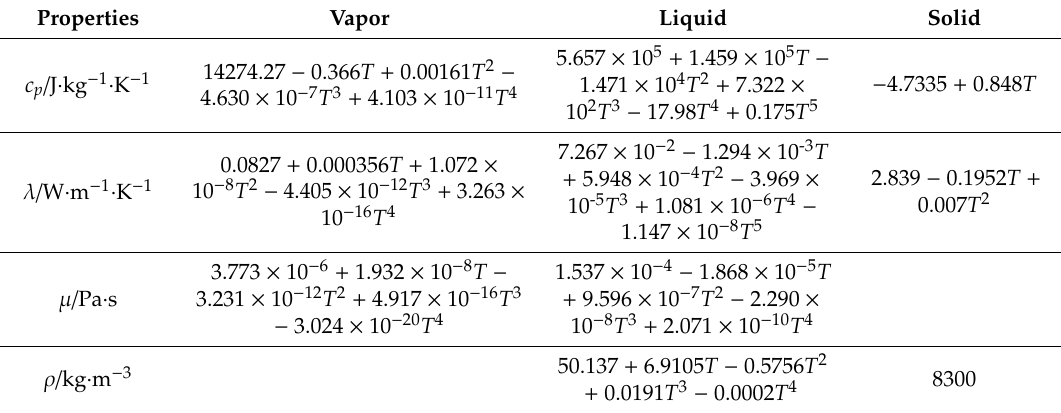
Table 1. Thermo-physical properties of the fluid and solid.